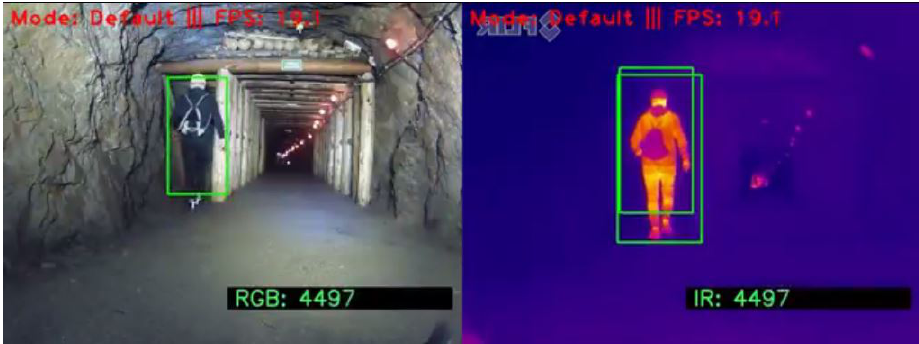
Figure 13. Correct detection in RGB image and doubled in IR image with algorithm HOG.